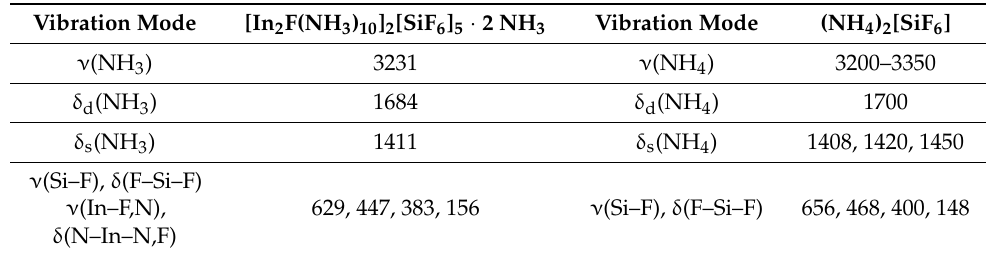
Figure 13. Single crystal Raman spectrum of [In 2 F(NH 3 ) 10 ] 2 [SiF 6 ] 5 · 2 NH 3 , excitation energy: 532 nm. Table 10. Comparison of the observed Raman modes of [In 2 F(NH 3 ) 10 ] 2 [SiF 6 ] 5 · 2 NH 3 and (NH 4 ) 2 [SiF 6 ] in cm − 1